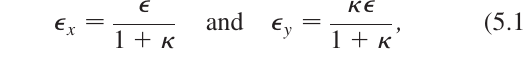
FIG. 11. Dynamic apertures in ELEGANT (left) simulation for 50 sets of random errors (red) and without errors (black) and in LEGO (right) for 10 sets of random errors (dash), the average aperture (green), and aperture without errors (red).